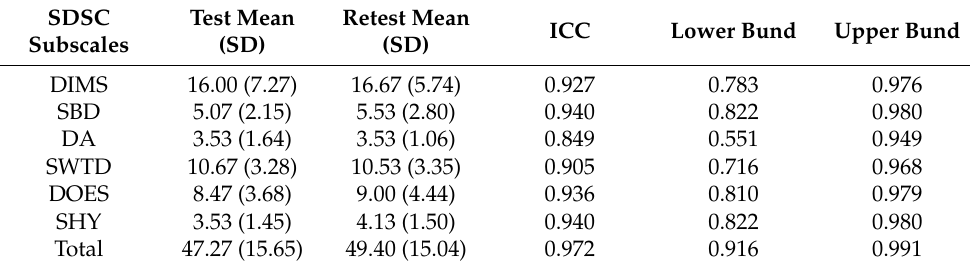
Table 3. Test–retest reliability of the SDSC.